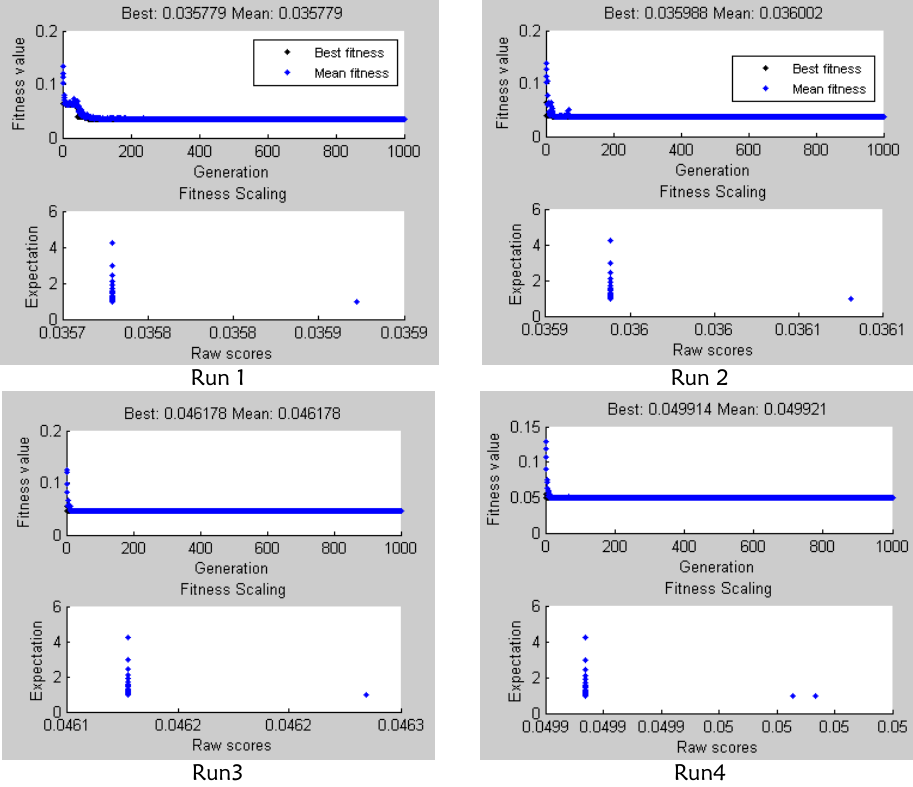
Figure 2: four different runs for 1000